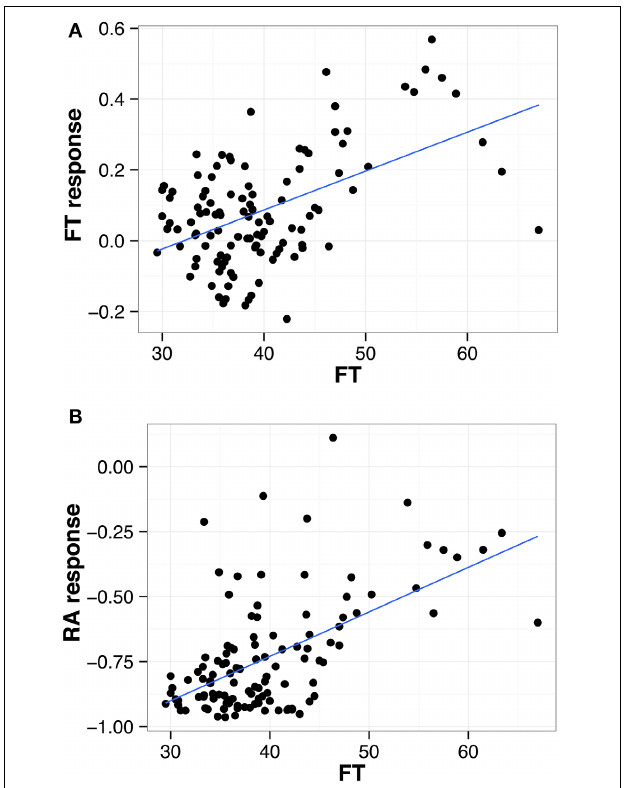
FIGURE 1 | Correlation between flowering time (FT) and (A) FT in response to water deficit and (B) rosette area (RA) in response to water deficit. Each dot represents one of the 117 L er x An-1 RILs (ww and wd; Tisné et al., 2010). The regression for all points is shown as a solid blue line.